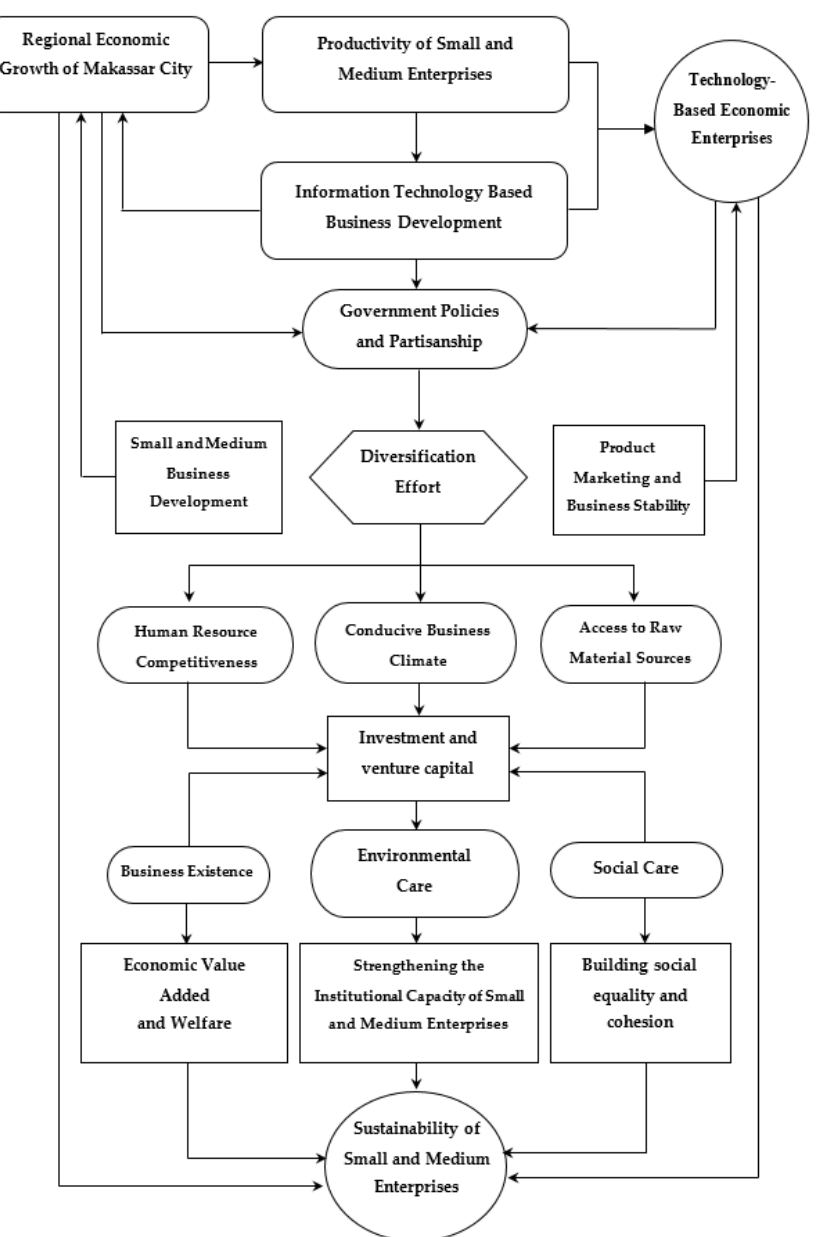
Figure 8. The sustainability of SMEs in Makassar City.